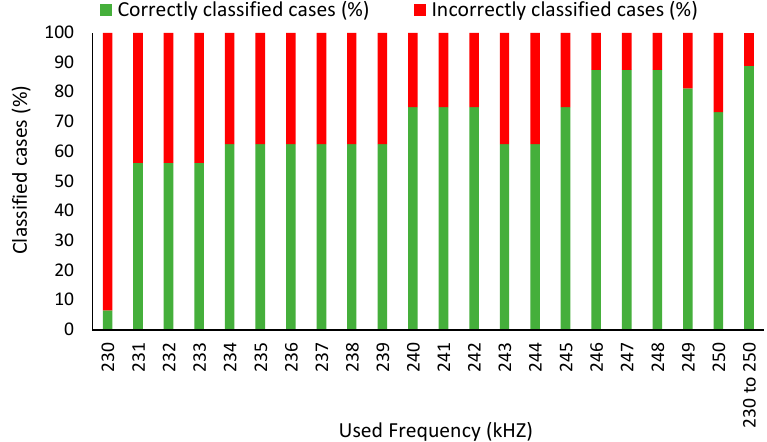
Figure 13. Correctly classified cases with the PNN when a single frequency is